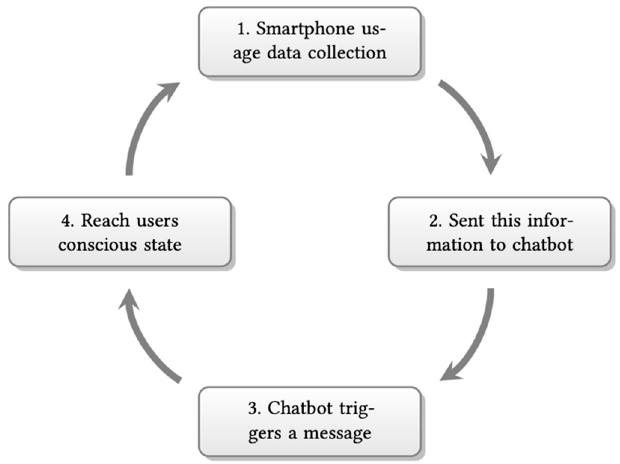
Figure 1. Step-by-step operation of the proposed application, which uses a conversational agent to mitigate the smartphone overuse problem.